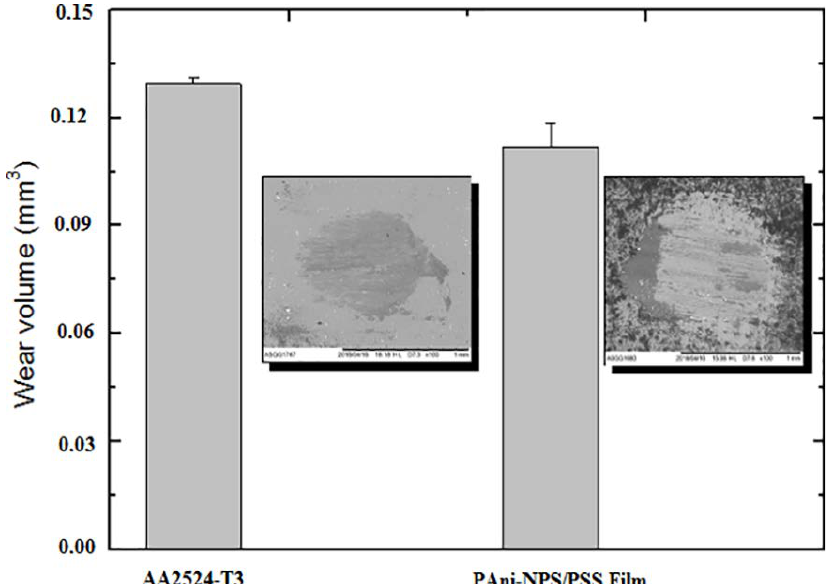
Figure 6. Wear volume for the AA2524-T3 alloy with and without PAni-NPs/PSS bilayers.